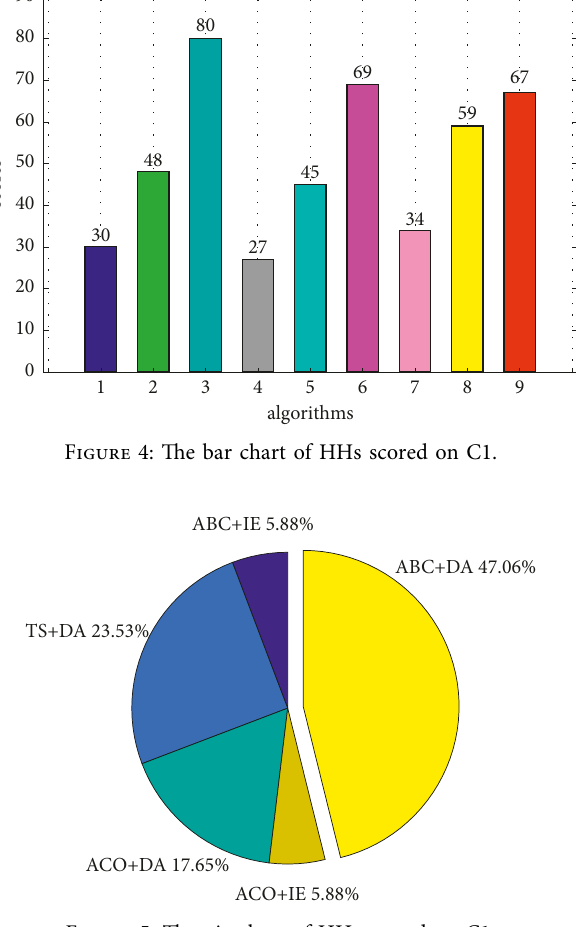
Figure 5: The pie chart of HHs scored on